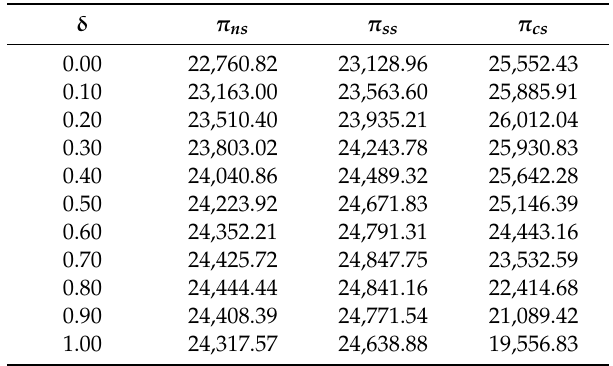
Table 6. Total profit of the supply chain under di ff erent